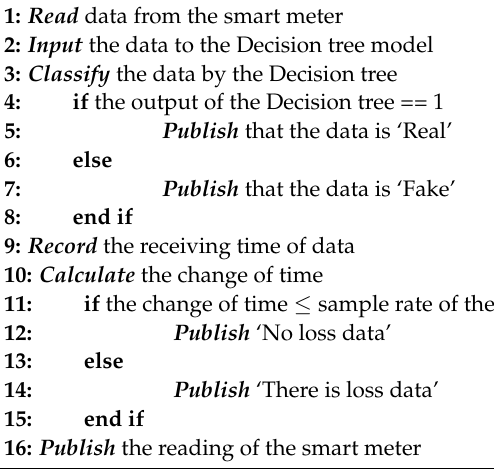
Algorithm 1 The pseudo-code of data acquisition, validation, and visualization